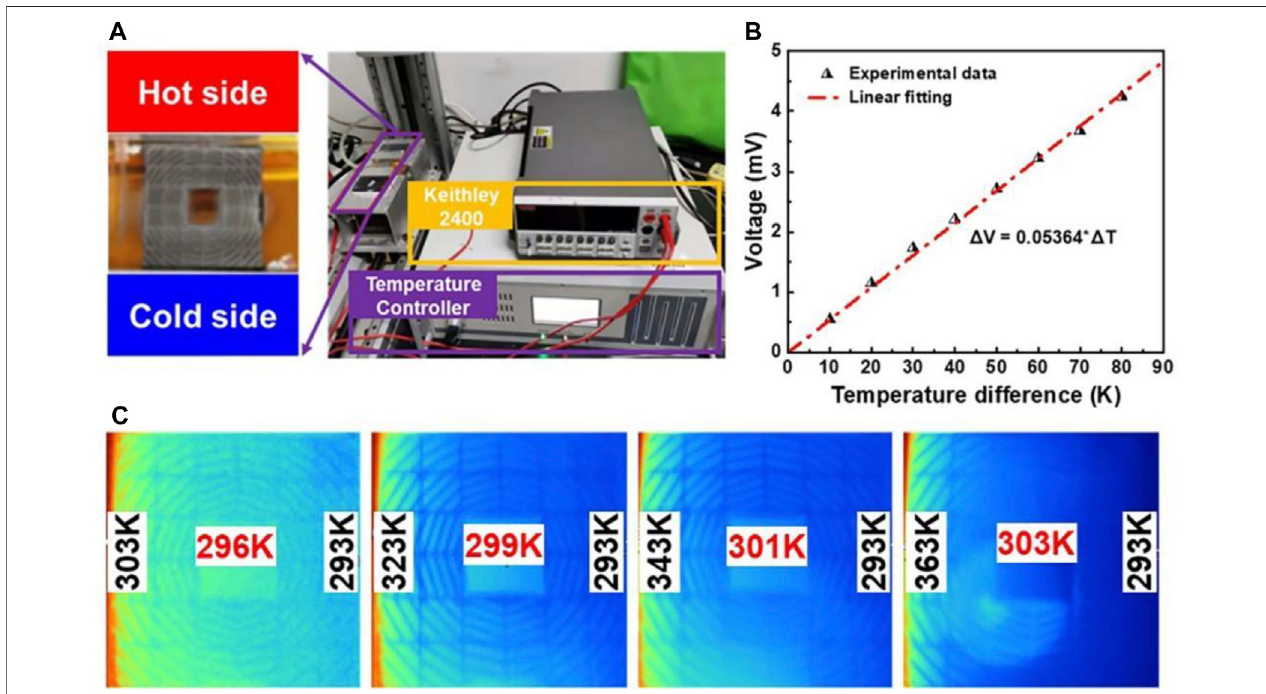
FIGURE 5 | (A) Picture and test drawing of the dual-functional thin- fi lm thermal meta-device. (B) Relationship between the output voltage of the device and the temperature difference set ( Δ T z = 10~80 K). (C) Surface views of temperature distribution of the meta-devices while the hot sides are set to 303, 323, 343, and 363 K. The temperature of the cold side is set to 293